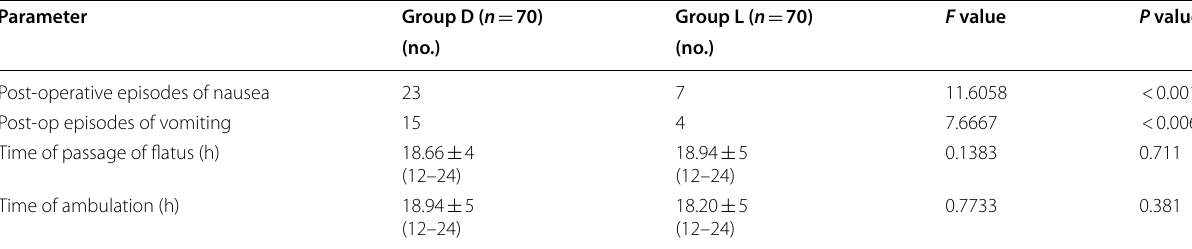
p value < 0.05 is considered